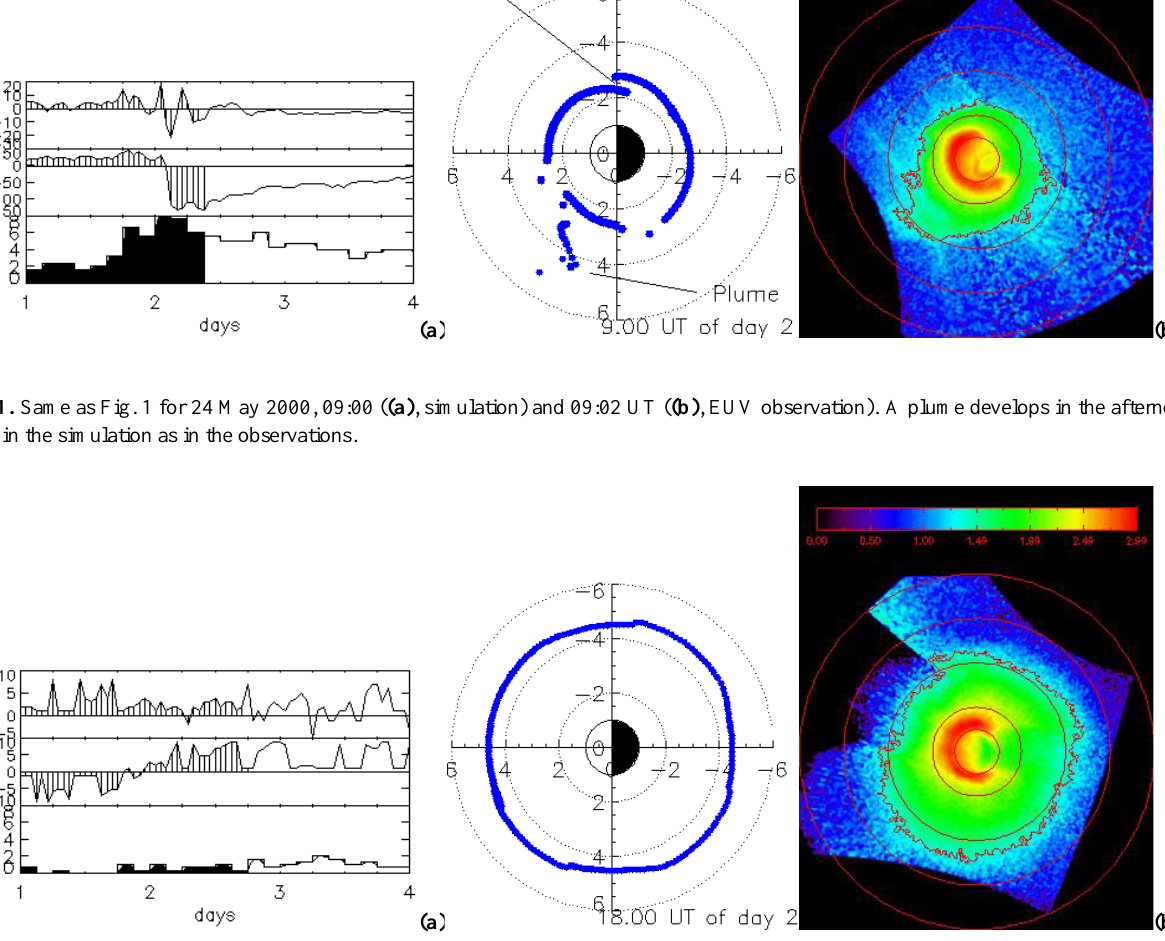
(right panel (b), EUV observation). Fig. 12. Same as Fig. 1 for 2 May 2001, 18:00 ( (a) , simulation) and 17:58 UT ( (b) , EUV